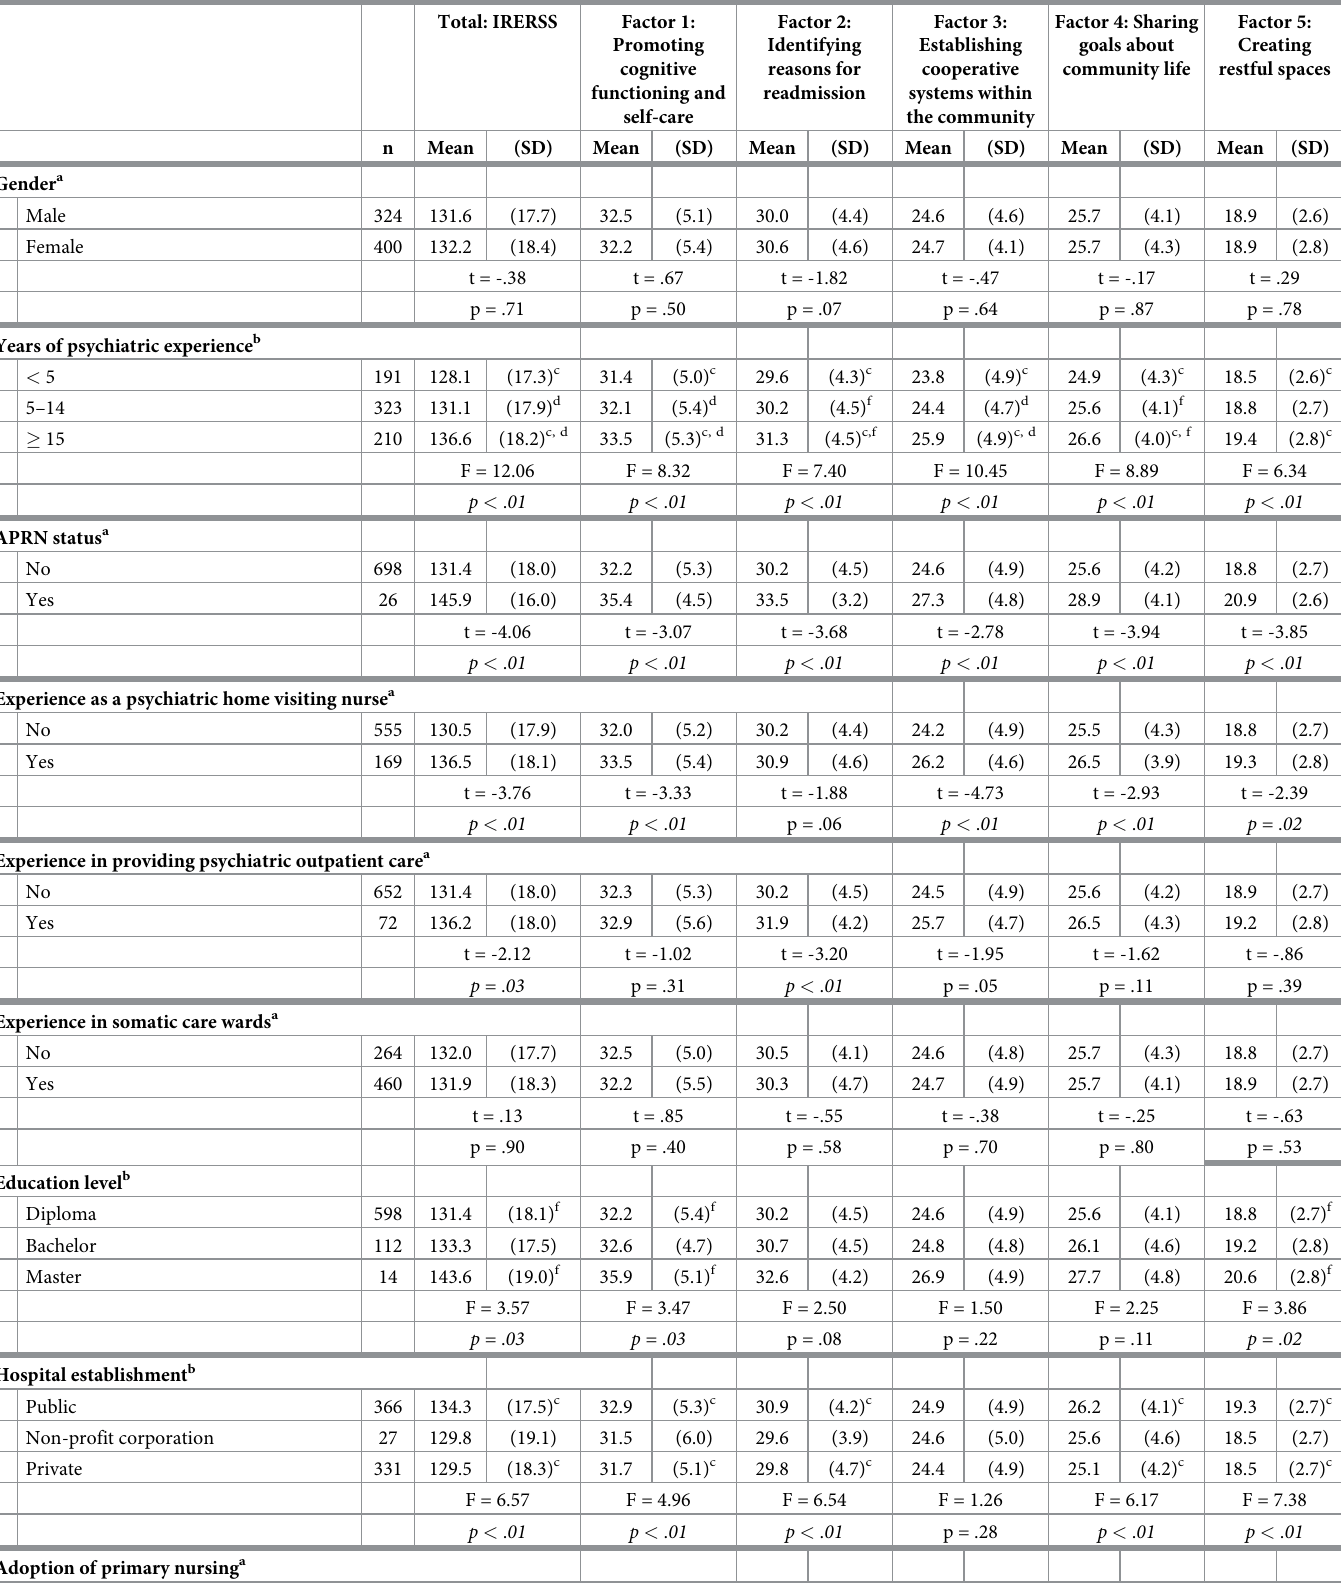
Table 4. Univariate analyses of the IRERSS (n = 724).